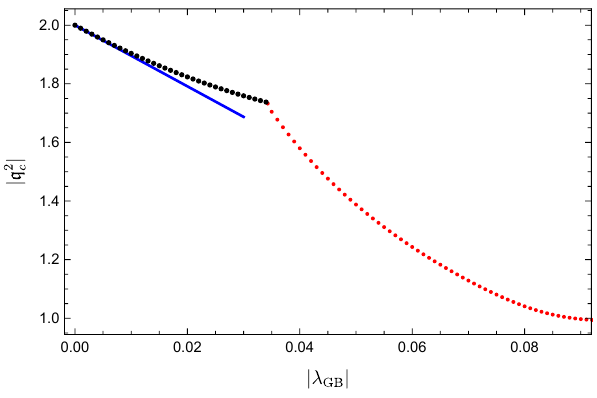
Figure 16 . Radius of convergence of the hydrodynamic sound mode in the Einstein-Gauss-Bonnet theory as a function of the magnitude of the higher-derivative coupling λ line is the linear approximation (4.18). Black dots are the non-perturbative result for the radius of convergence arising as shown in figure 14, left panel. Red dots are the radius of convergence arising as a result of the level-crossing between the sound mode and the non-perturbative mode (see figure 15, top left panel). The transition between the two regimes occurs at λ